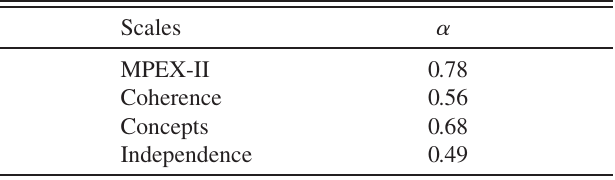
its three dimensions.